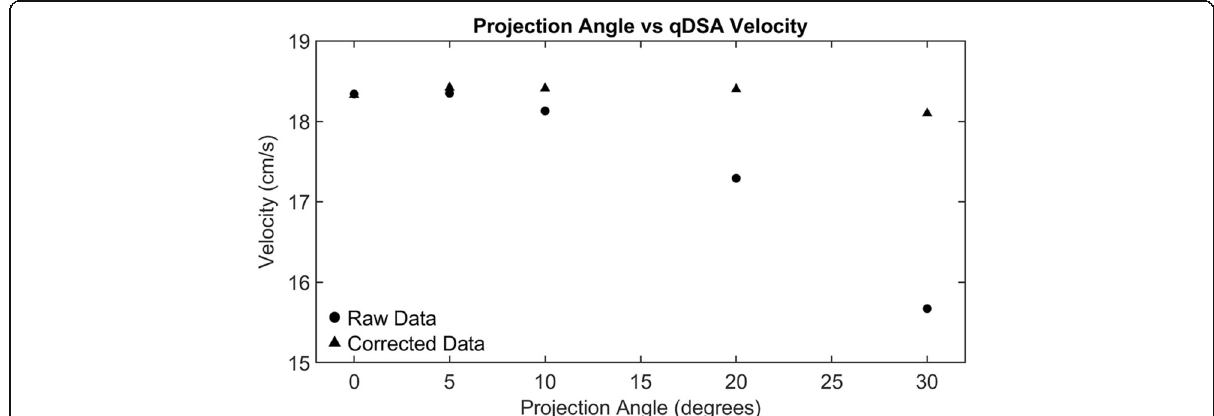
Fig. 3 The raw qDSA velocity calculations as a function of projection angle are plotted as circles. As the projection angle increases the calculated velocity values decrease as a function of cosine the projection angle. Applying the projection angle correction reduces variation in the calculated velocity over a range of projection angles